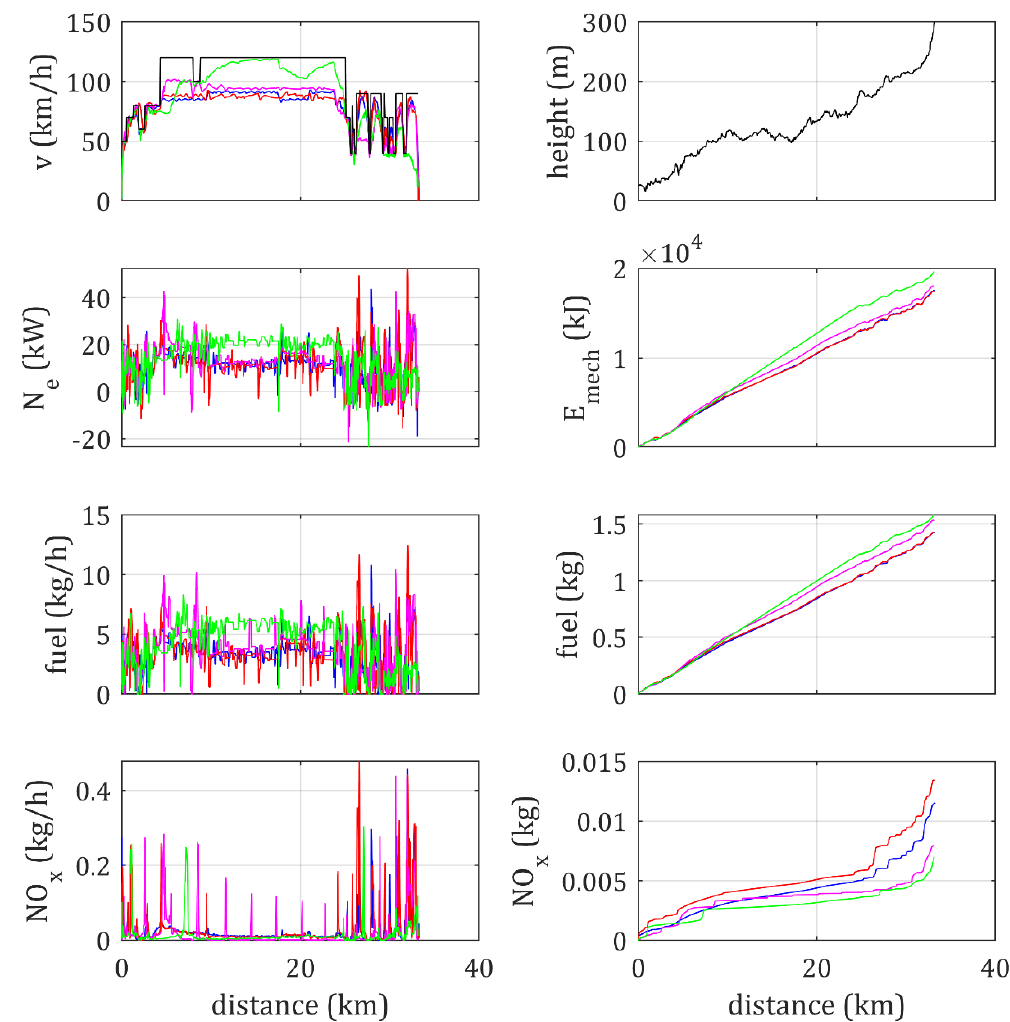
Figure 8. Engine parameters for minimum fuel consumption (blue), for minimum NOx production (green) and for two arbitrary driving profiles (red and magenta).